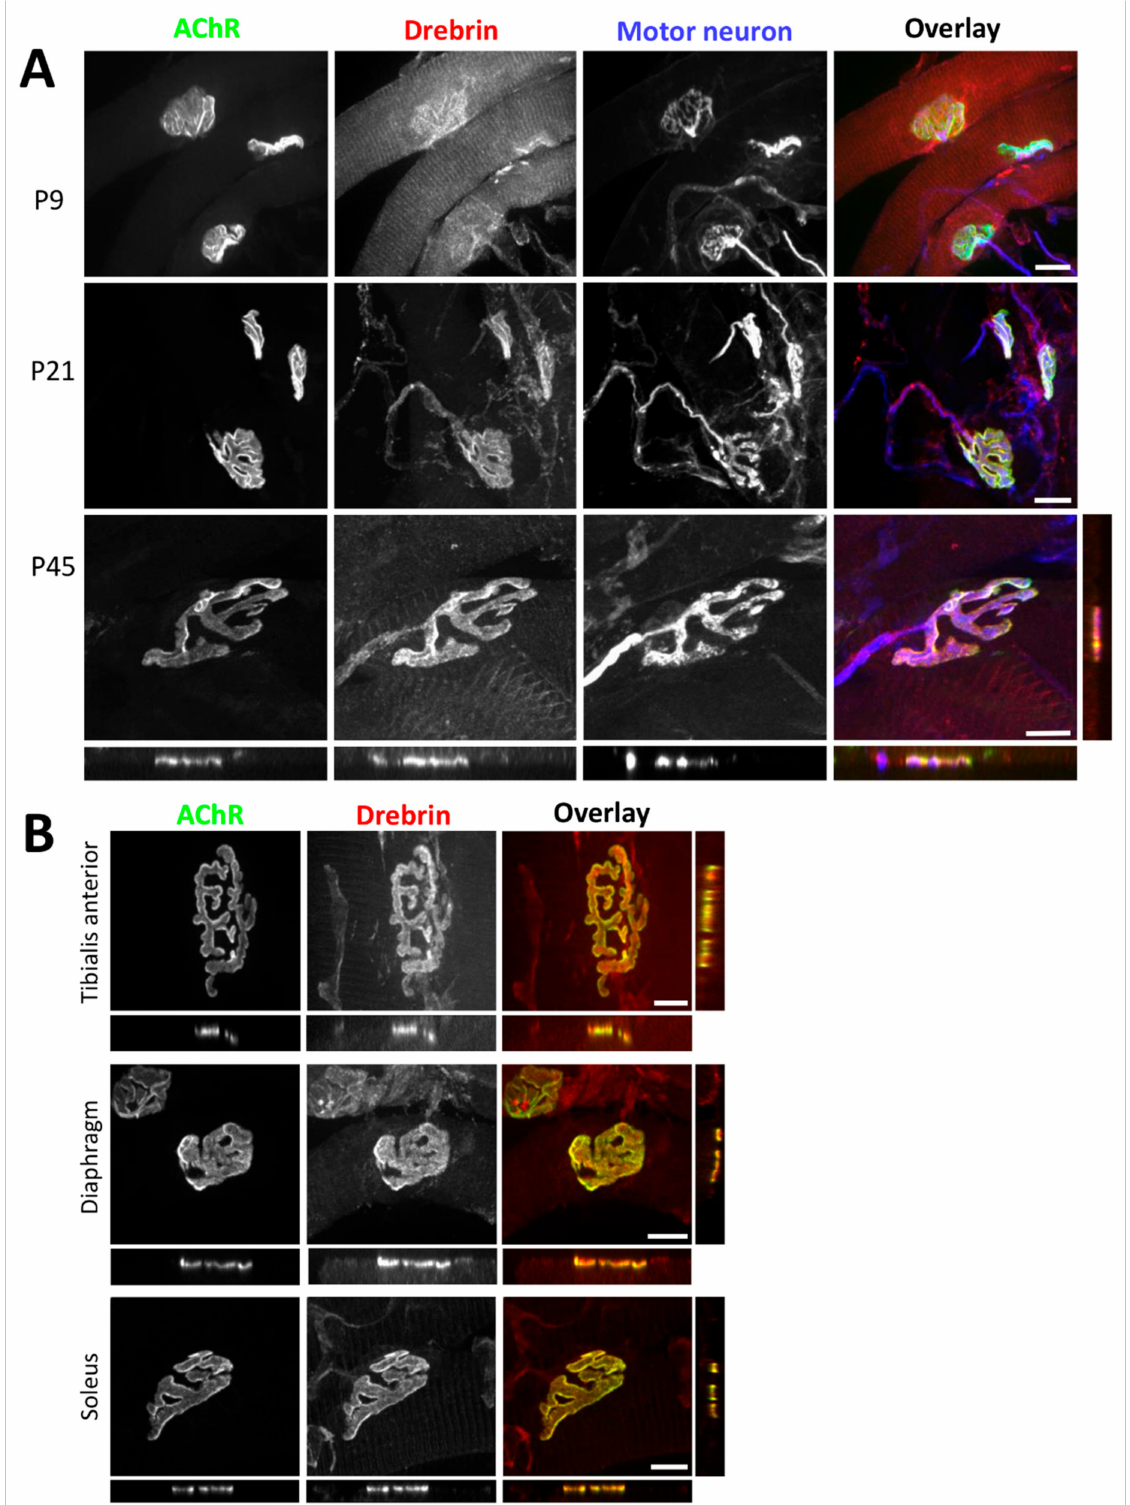
Figure 1. Drebrin localizes to the neuromuscular junction pre- and postsynaptic machinery. ( A ) Colocalization of drebrin (red) with bungarotoxin-labeled (BTX) acetylcholine receptor (AChR) clusters (green) and motoneuron (blue) in mouse triangularis sterni muscle during different postnatal stages (P9, P21, and P45). Bottom and right panels show an orthogonal view of P45 with visible colocalization of drebrin and AChRs. ( B ) Colocalization of drebrin (red) with AChRs (green) in fast-twitch ( tibialis anterior , diaphragm ) and slow-twitch ( soleus ) muscle types at P30. Bottom and right panels show orthogonal views. Scale bars—10 µ